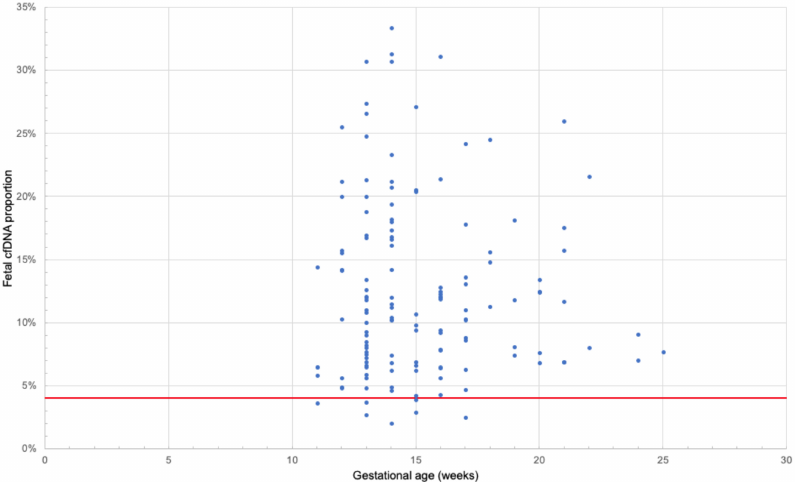
Figure 4. The proportion of fetal DNA (Y axis) versus the gestational age of 139 samples of the control set (X axis), calculated based on the results of amplifet library sequencing. The solid red line indicates a 4% proportion of fetal